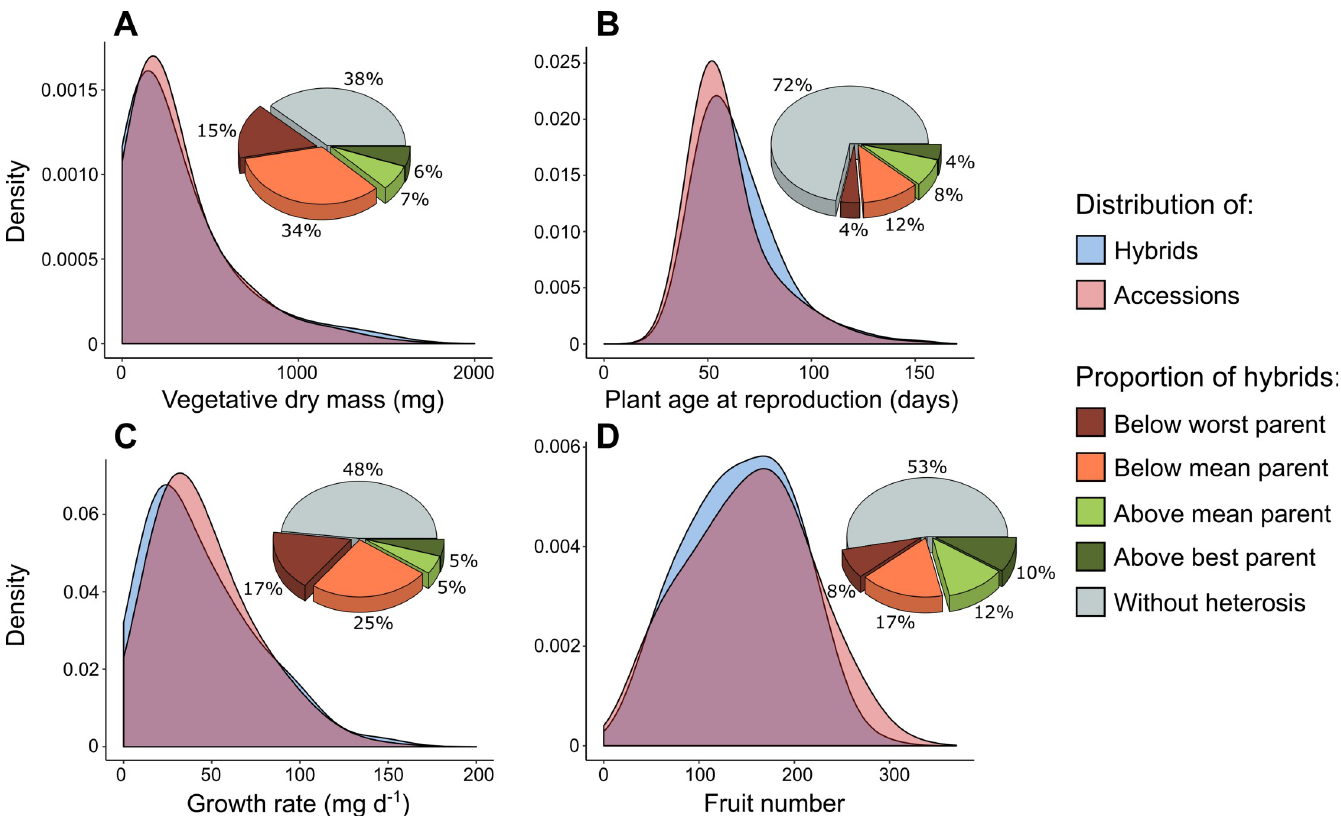
Fig 4. Distributions of traits and proportion of heterosis. (A) Vegetative dry mass M in accessions (red) and hybrids (blue). Pie chart indicates proportion of crosses without and with significant heterosis. (B) Plant age at reproduction. (C) Growth rate. (D) Fruit number. Density represents KDE. KDE, kernel density